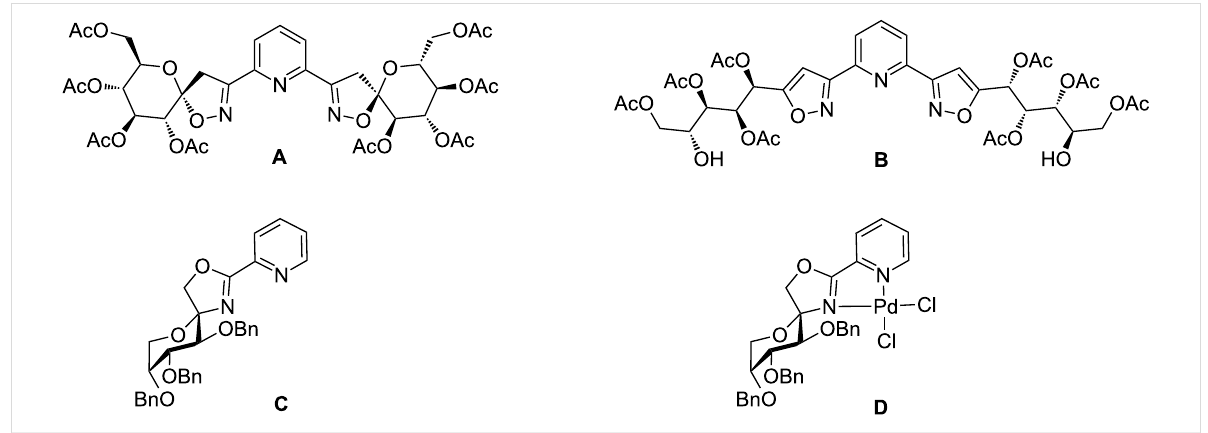
Figure 1: Pd-catalyzed cleavage of spiro-bis(isooxazoline) ligand A to isoxazole B and Pd-complex D prepared from spiro-oxazoline C